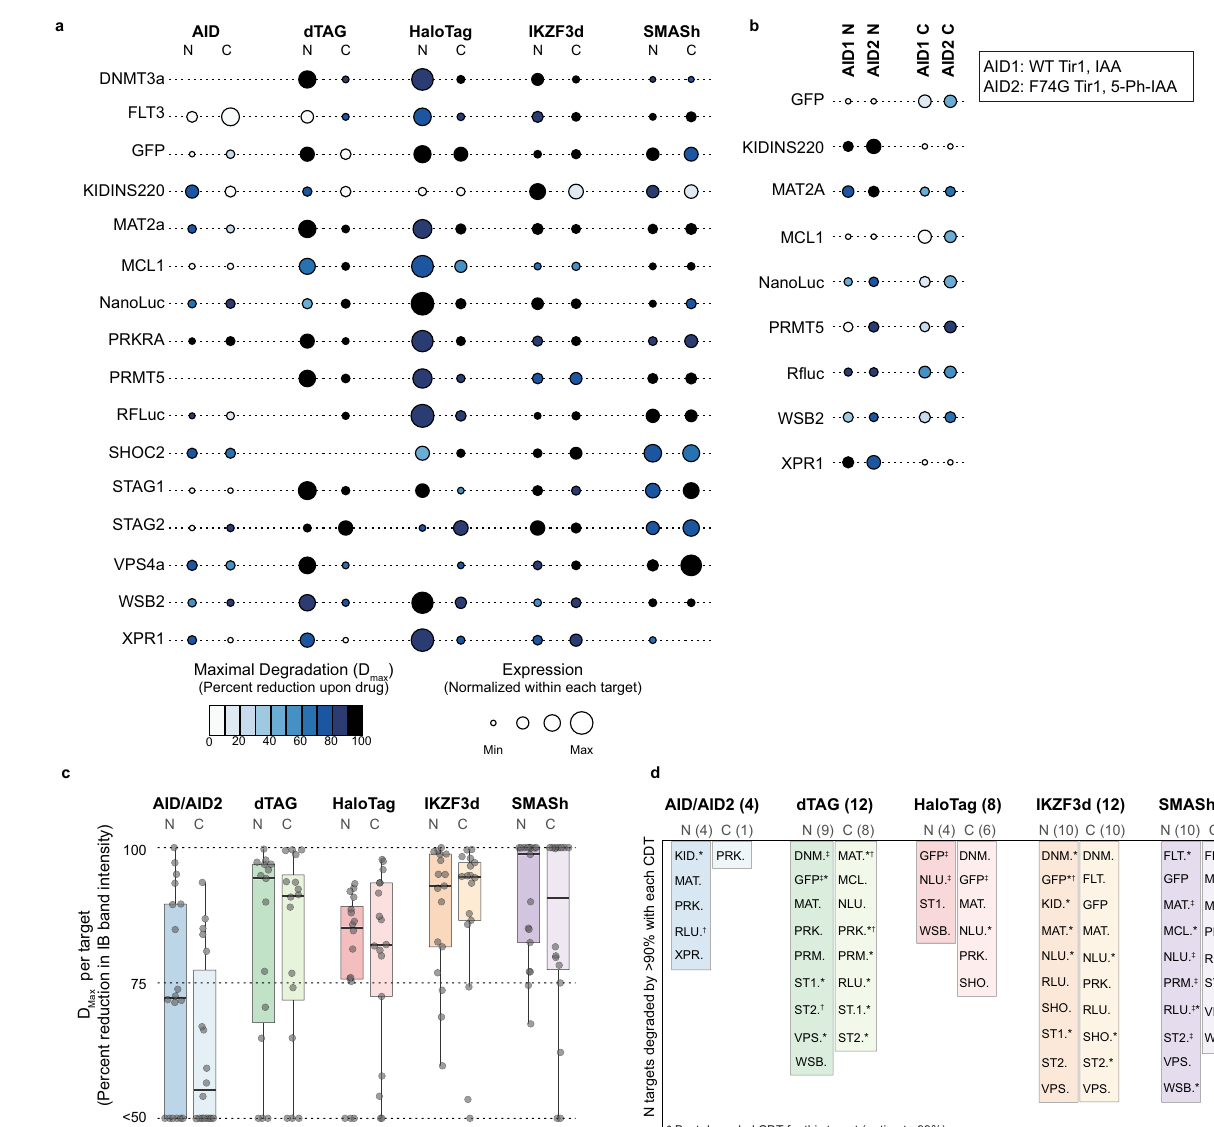
showninSupplementaryFigs.9,10. b ComparisonofAIDandAID2systemsfornine POI. The indicated AID fusions were expressed in HEK-293T cells co-expressing Tir1 (eitherwildtypeforAIDandorF74GforAID2).Cellsweretreatedwithdrug(Indole-3- aceticacidforAIDor5-phenyl-indole-3-aceticacidforAID2),andproteinlevelswere analyzed by immunoblot (see Supplementary Fig. 8). Protein expression is normal- ized as in a . c The D max observed for each fusion protein categorized by degron technologyandfusionterminus.Theboxandwhiskerplotindicatesthemedian,the fi rst and third quartiles, and 1.5x the interquartile range. N =16 targets analyzed for eachconstructexceptdTAG-N,where N =15. d POI-CDTfusionsthatweredegraded by >95%. NLU. NanoLuc, RLU. RFluc, PRM. PRMT5, WSB. WSB2, MCL. MCL1, SHO. SHOC2, MAT. MAT2A, VPS. VPS4A, PRK. PRKRA, ST1. STAG1, ST2. STAG2,